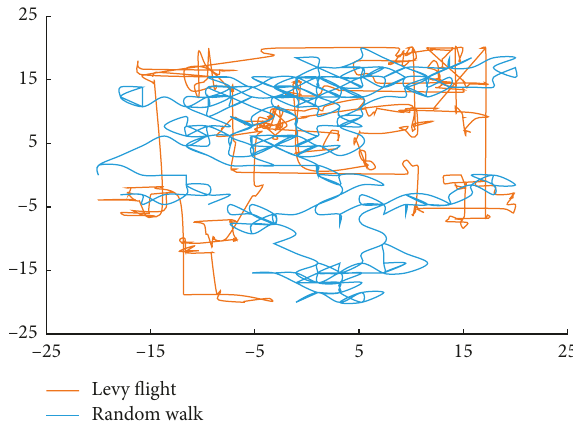
Figure 2: A typical searching process with 500 times of Levy